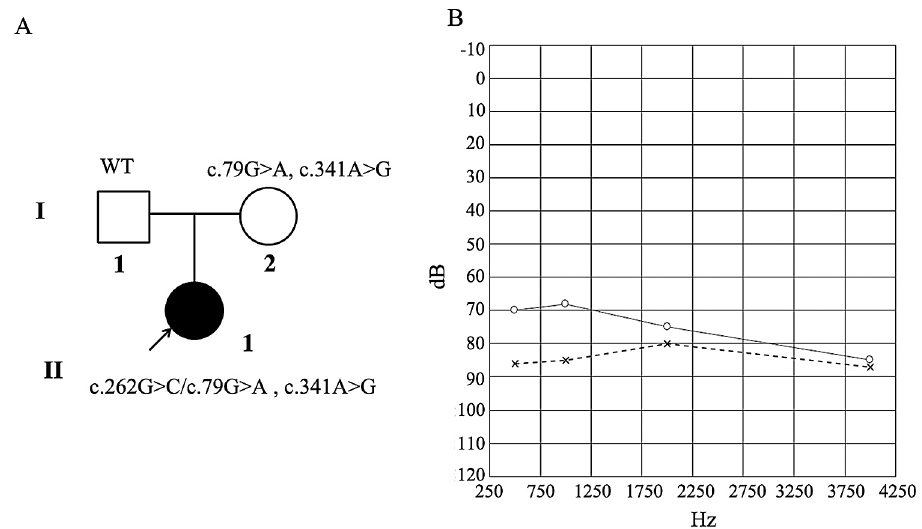
Figure 1. Genetic characteristics of the family, the pedigree of the family (A) and audiograms for the proband (B). The horizontal axis of the audiogram shows the tone frequency (Hz) and the vertical axis displays hearing level (dBHL). Severe hearing loss was classified as a pure-tone average between 70-95 dBHL. х , left ear, о , right